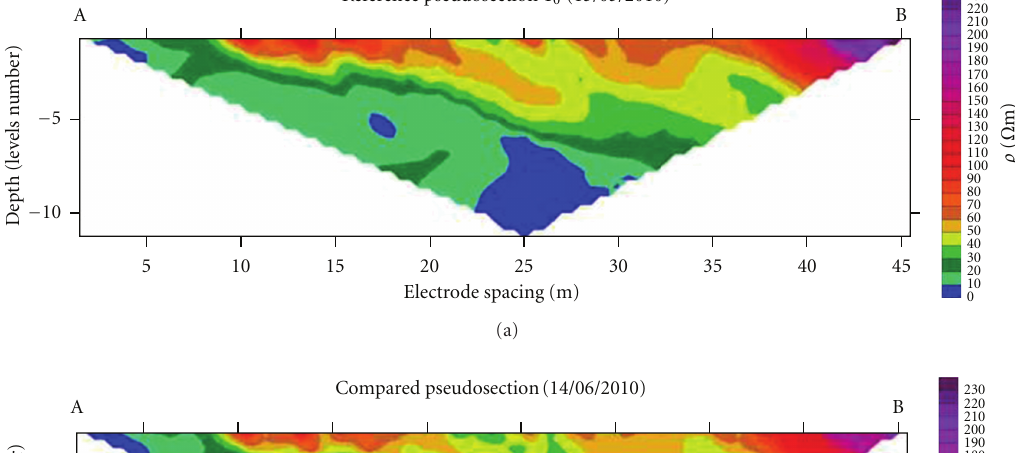
of the pseudosections and negative variations in the